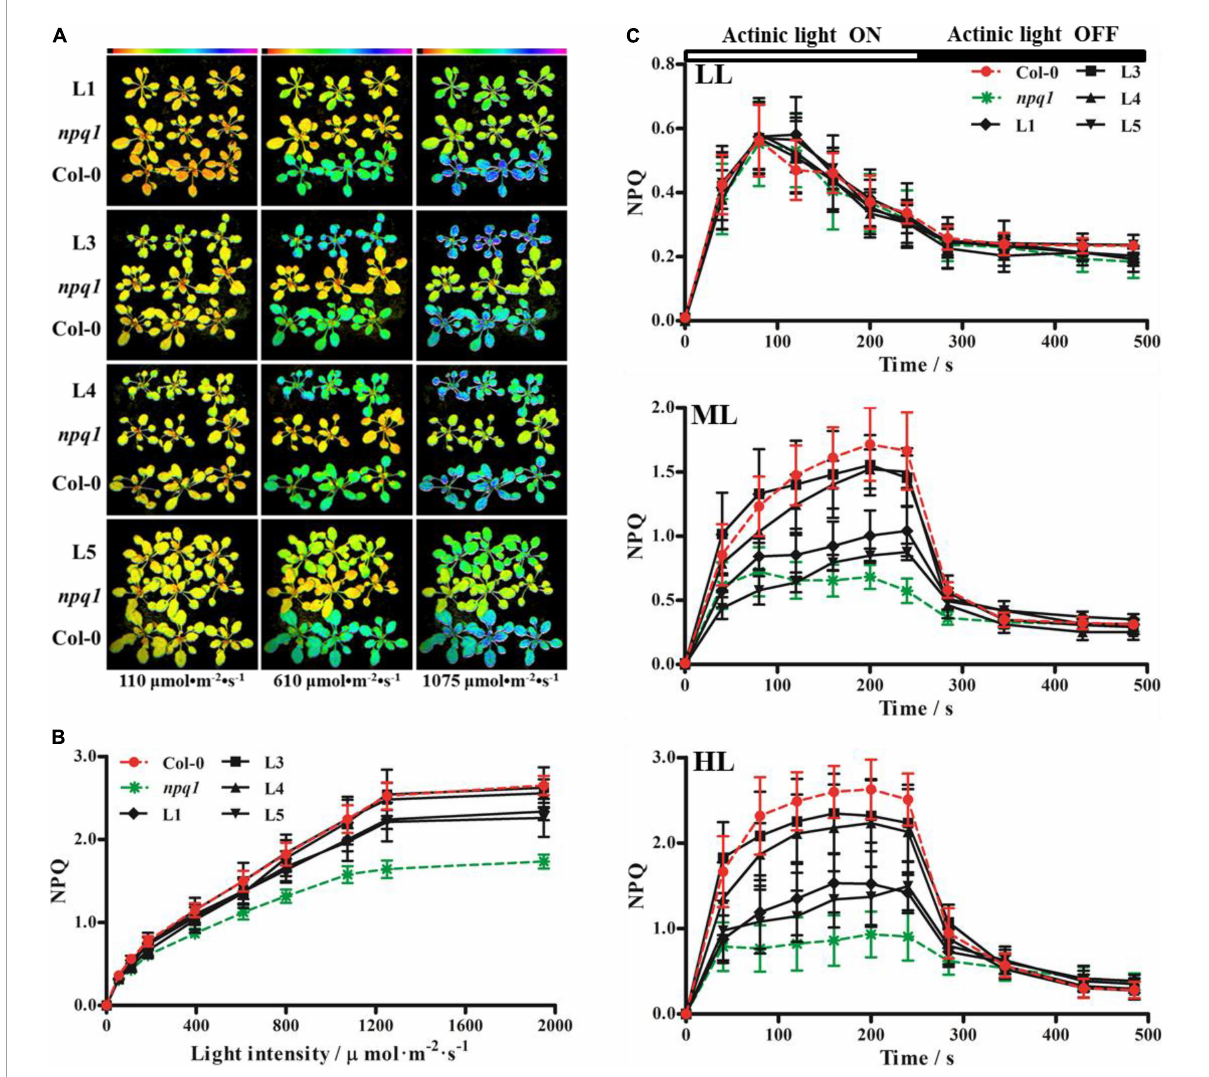
FIGURE5 Non-photochemical quenching (NPQ) of Col-0, npq1, and PeVDE transgenic plants. (A–C) Chlorophyll fluorescence images (A) , NPQ (B) , and NPQ kinetics (C) of Col-0, npq1, and transgenic plants at different actinic light intensities. LL, 110 µ mol · m − 2 · s − 1 ; ML, 610 µ mol · m − 2 · s − 1 ; HL, 1,075 µ mol · m − 2 · s − 1